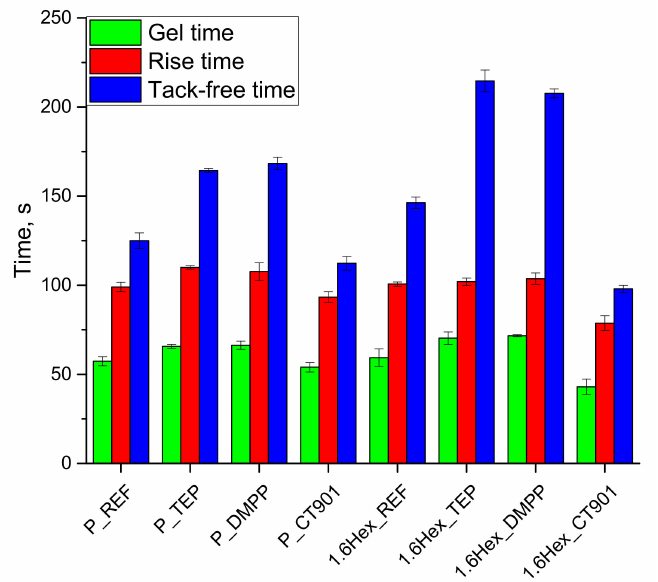
Figure 3. Characteristic processing times during the synthesis of PUR foams.